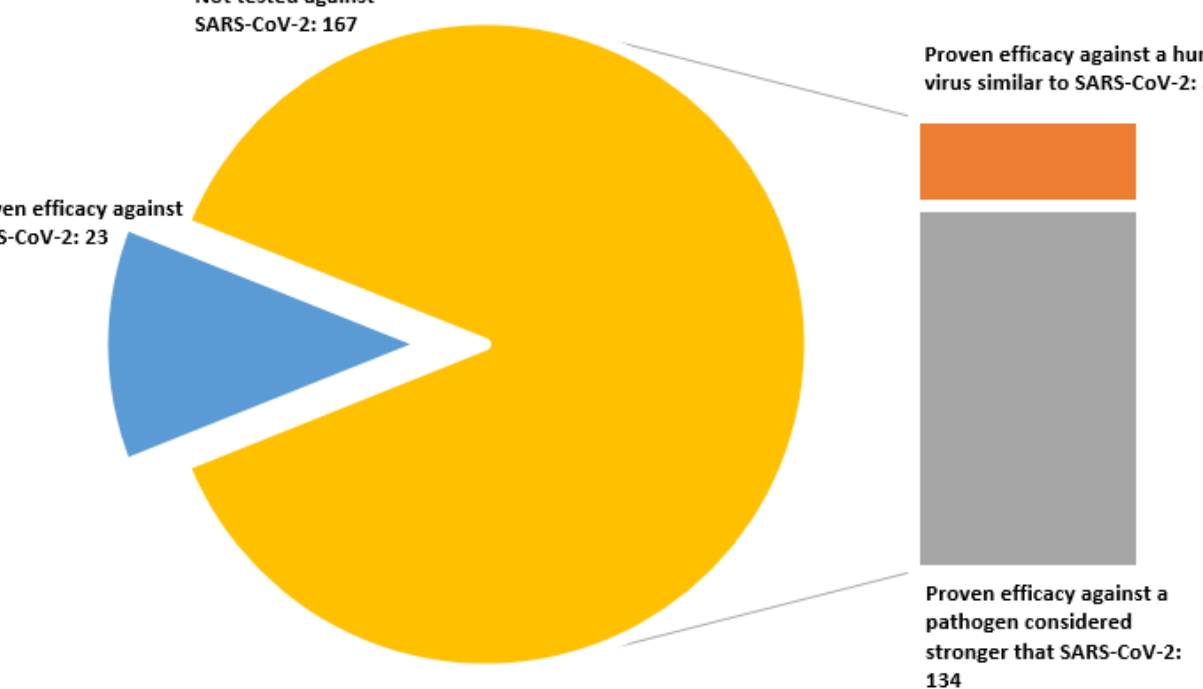
Figure 1. Commercial products authorized to be employed in the food industry (either requiring post-rise or not) against SARS-CoV-2 according to the EPA List N grouped by their acceptance